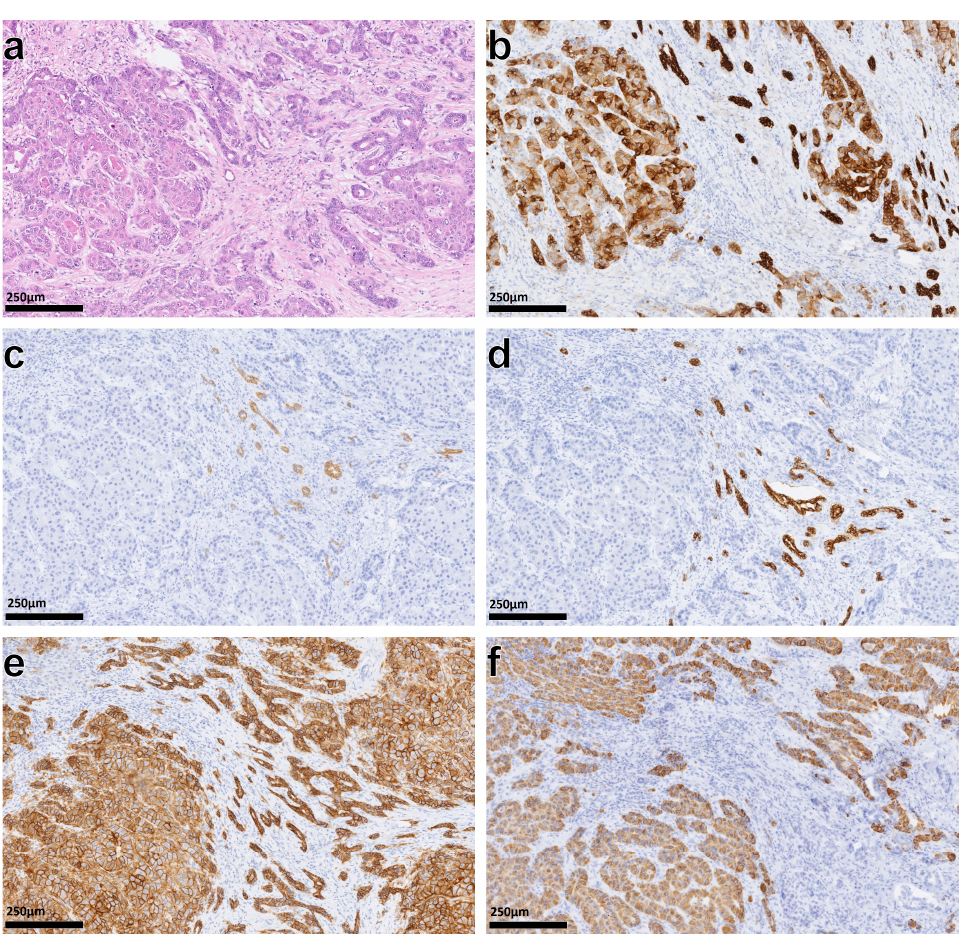
Figure 2. Histopathological image of mixed hepatocellular cholangiocarcinoma ( a ) with unequivocal hepatocytic (bottom left) and cholangiocytic (top right) areas of differentiation. Immunohistochemistry demonstrates the biphenotypic nature of the tumor. The tumor shows positivity for cholangiocytic markers (( b ), CK 7) and focally prominent markers of stem cell differentiation (( c ), CD56 and ( d ), CK19). Usually absent in hepatocellular carcinomas, this tumor expresses BerEp4 ( e ) and, in most areas, Hepar1, a marker of hepatocytic lineage ( f ).